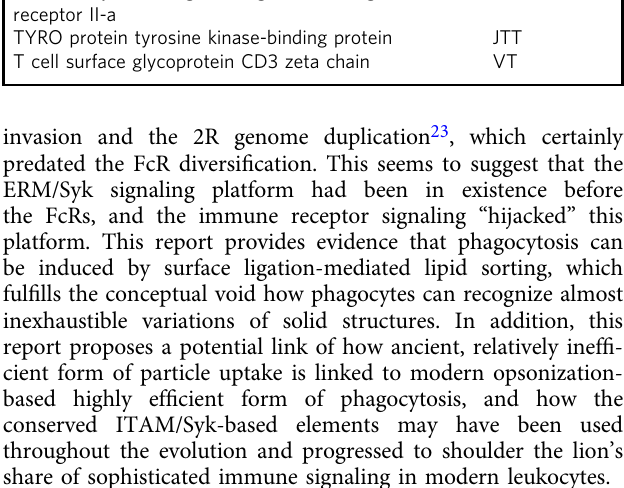
Table 2 Amino acid substitution models selected by SMS Protein Model